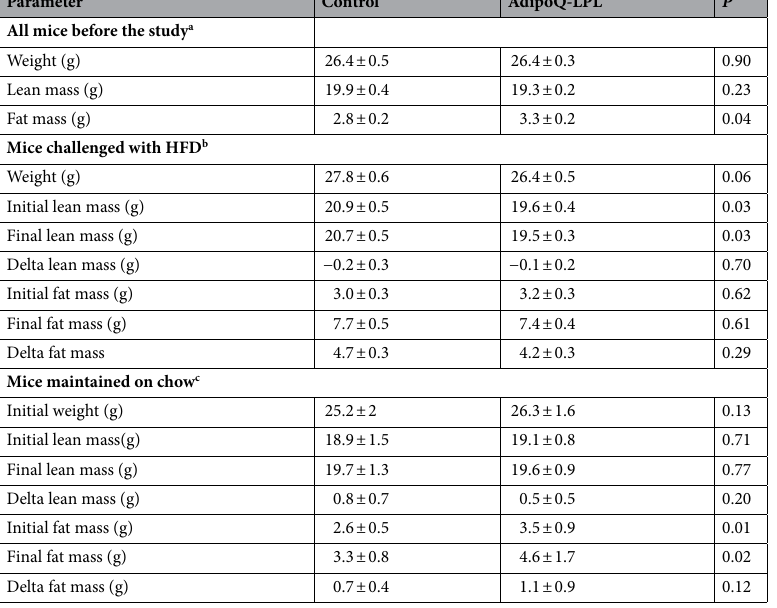
Table 1. ECHO MRI characterization of mice. a AdipoQ-LPL transgenic male mice and their littermate controls (age 9–9.5 weeks) were characterized by ECHO-MRI before and after an acute high fat diet challenge in calorimetry chambers; a group of mice was maintained on chow as a control group. These data are for the entire cohort (control n = 25; AdipoQ-LPL n = 23) before the study. Data are represented as means ± standard error of the mean. b AdipoQ-LPL transgenic male mice and their littermate controls were characterized in a 1-week chow and 1-week high fat diet (60% cal fat) feeding study in calorimetry chambers (n = 12 control and n = 12 AdipoQ-LPL per group). Data are represented as means ± standard error of the mean. c AdipoQ- LPL transgenic male mice and their littermate controls were maintained on chow (n = 13 control and n = 11 AdipoQ-LPL per group). Data are represented as means ± standard error of the